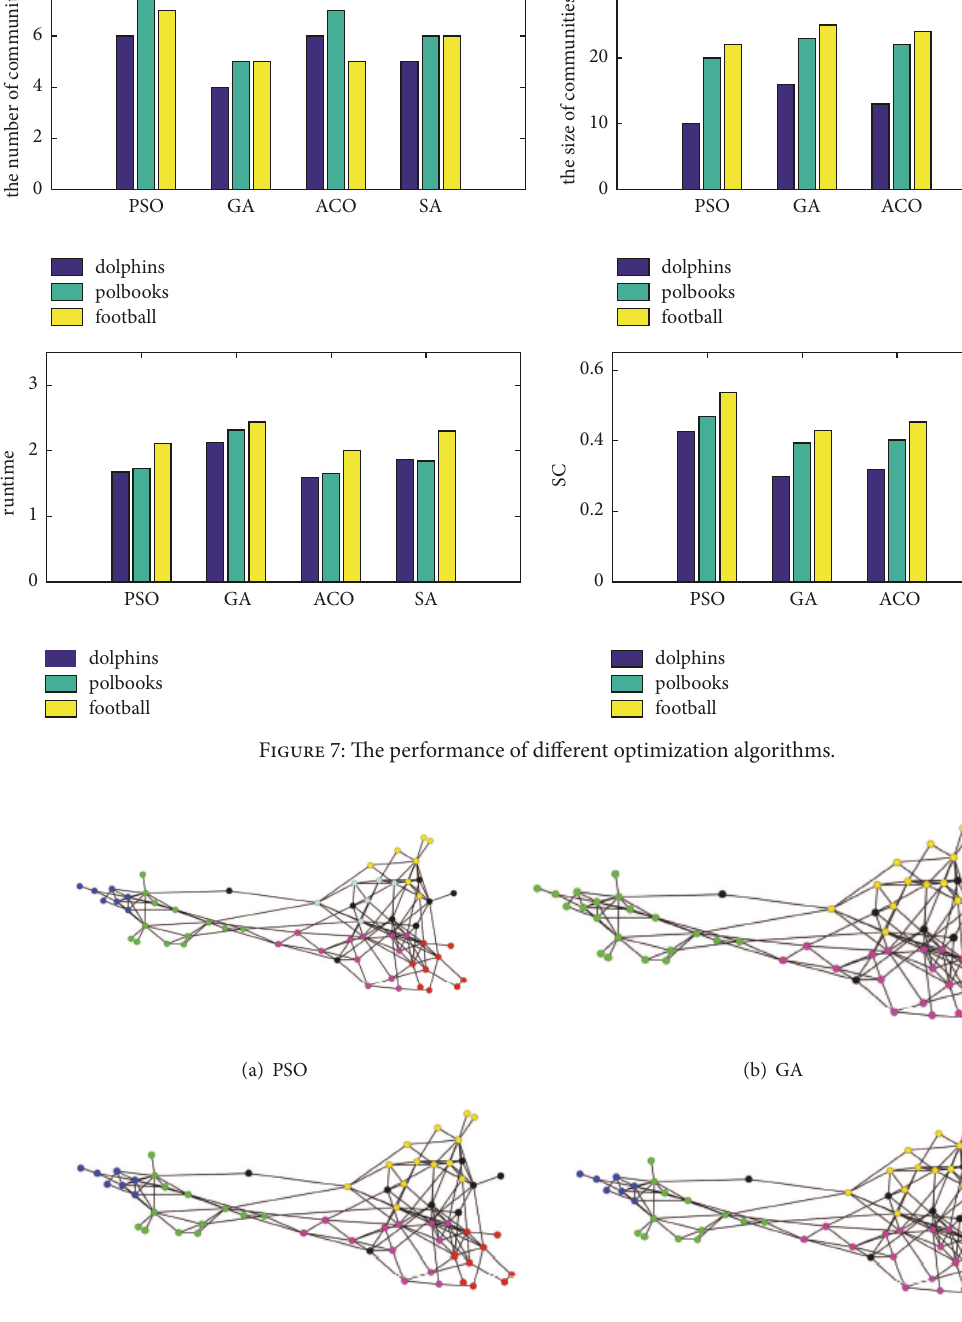
in Figure 7, the detected communities by PSO have a little small size and a bit more community numbers, which is in accordance with the topic distribution. As for runtime, PSO runs a bit slower than ACO but much better than